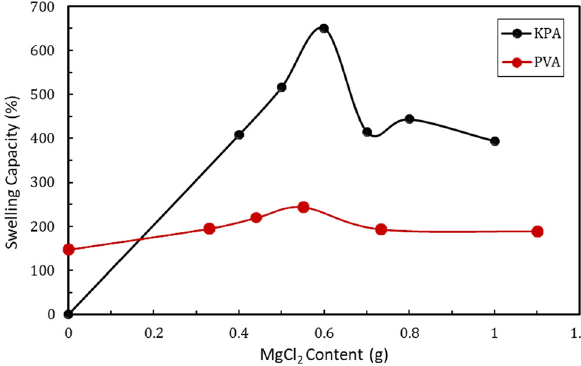
Figure 10: E ff ect of MgCl 2 content on swelling capacity.